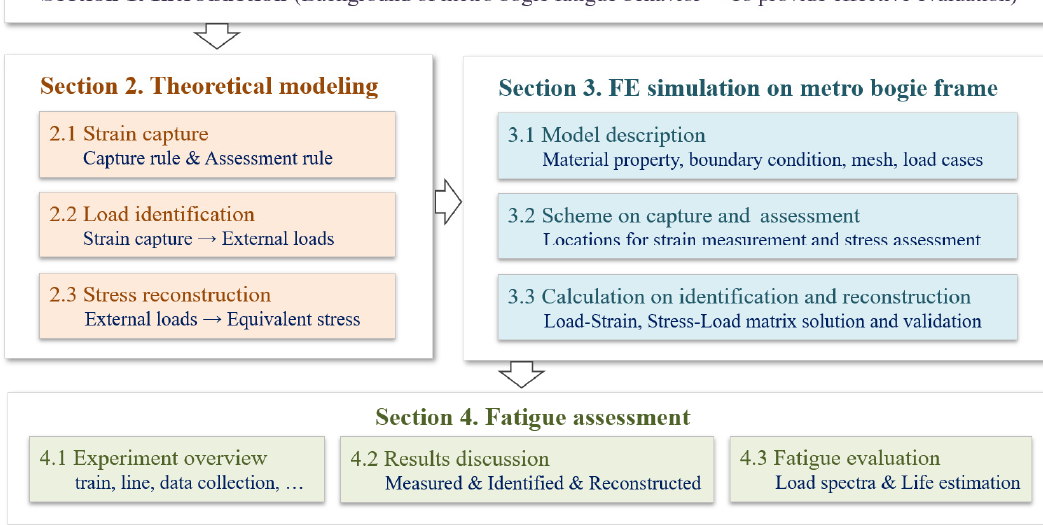
Figure 1. The framework of this paper.